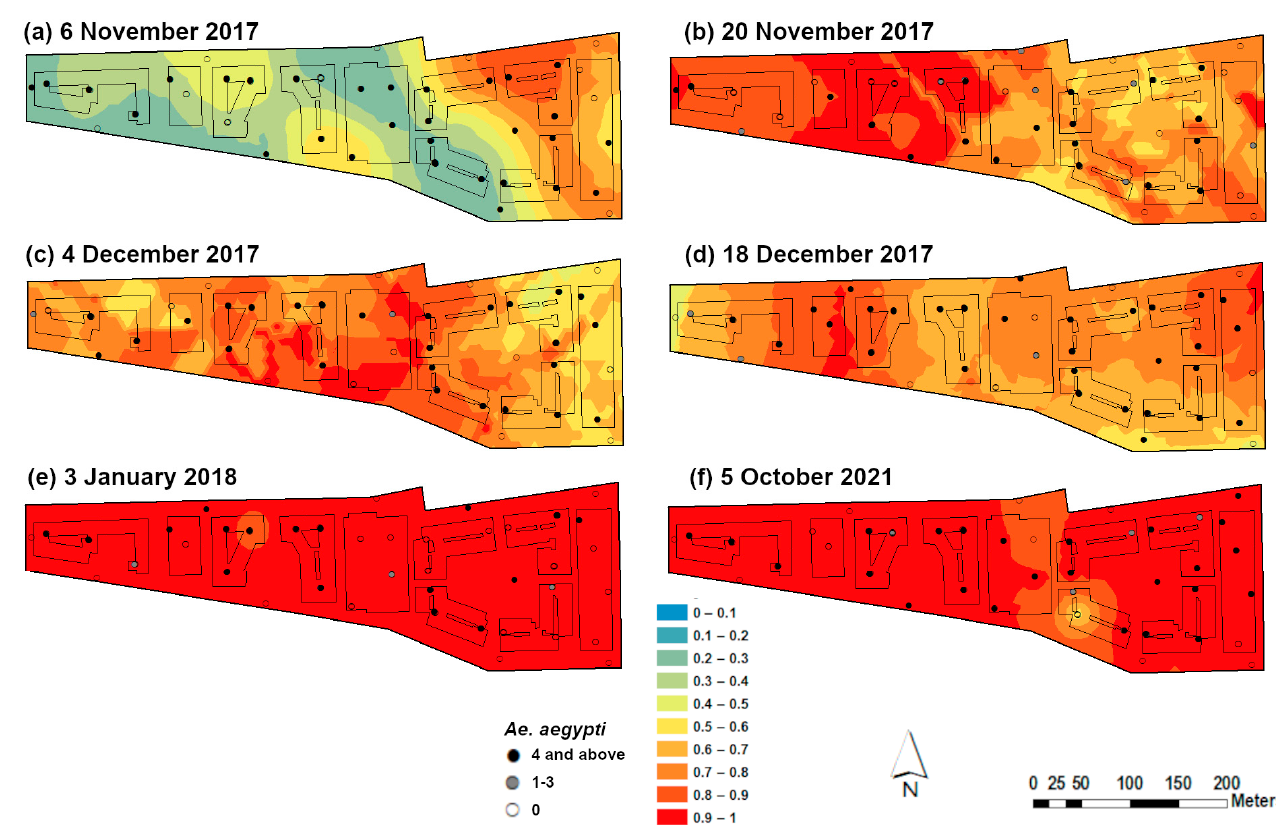
Figure 3. Spatial distribution of Wolbachia -infected mosquitoes in Mentari Court based on ordinary kriging. The analysis is only based on the ovitraps with four or more Ae. aegypti . Red colour indicates a higher frequency of Wolbachia -infected mosquitoes.